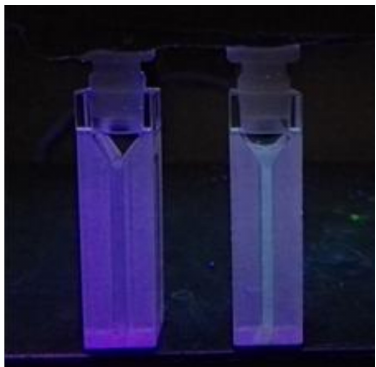
Figure 1. Image of BL21 after incubation with mannose-coated polymer ( right ) against untreated BL21 cells ( left ). Imaging was carried out under a transilluminator.